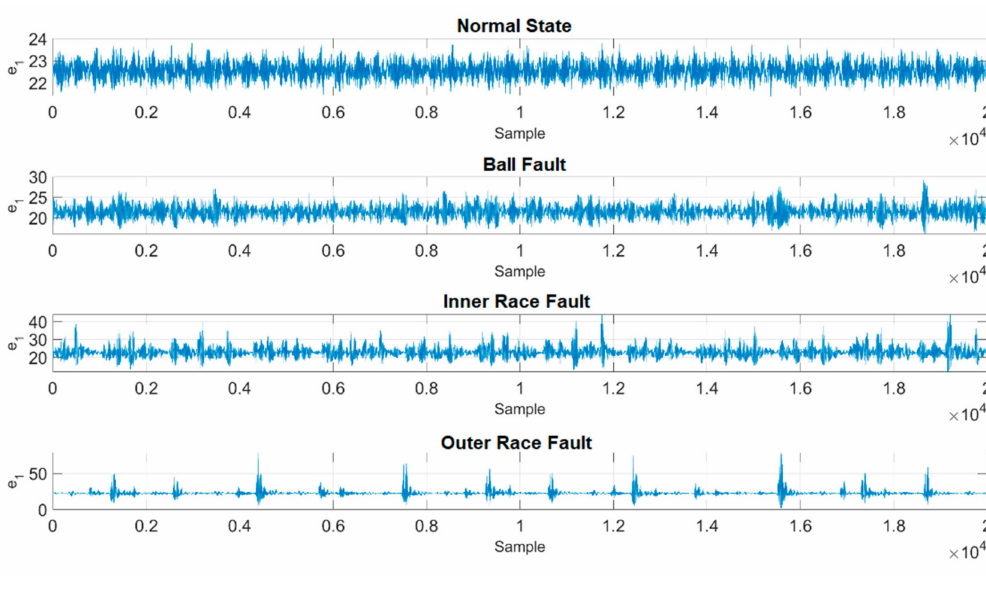
Figure 7. Time series of converted data in the chaotic domain.